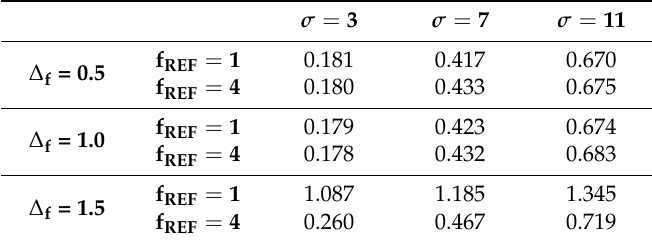
Table 4. Sensitivity analysis with simulated data, effect of atmosphere-like disturbances. RMSE (in radians) of the demodulated unwrapped phase at three different σ values (ramp gradient).